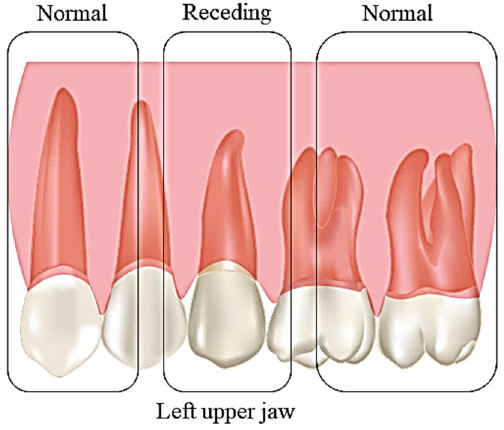
Figure 1. Comparison of normal gum and gingival recession.